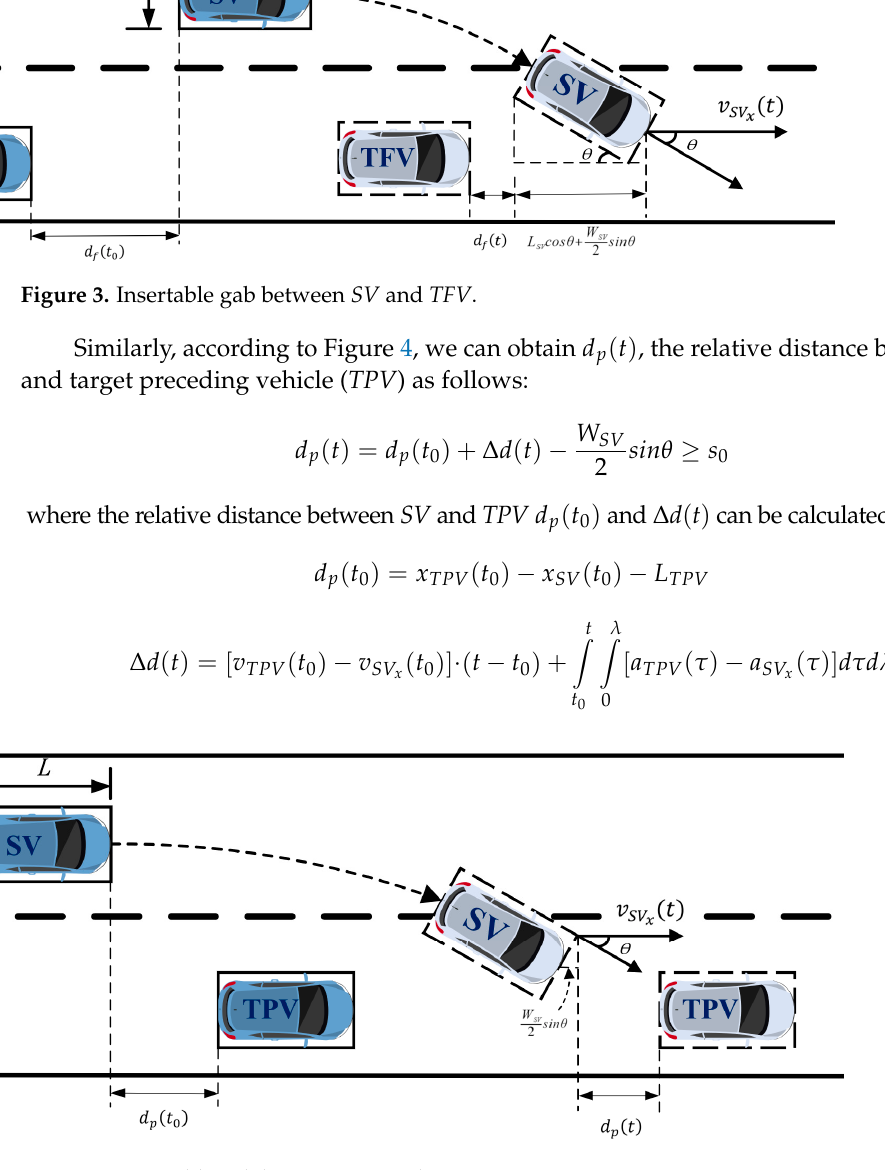
Figure 4. Insertable gab between SV and TPV.